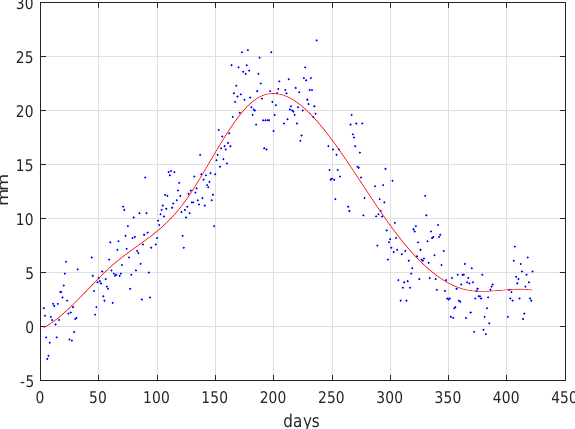
Figure 5. MDL index computed for the West antenna time series in the East (red line), North (green line) and Up (blue line) components